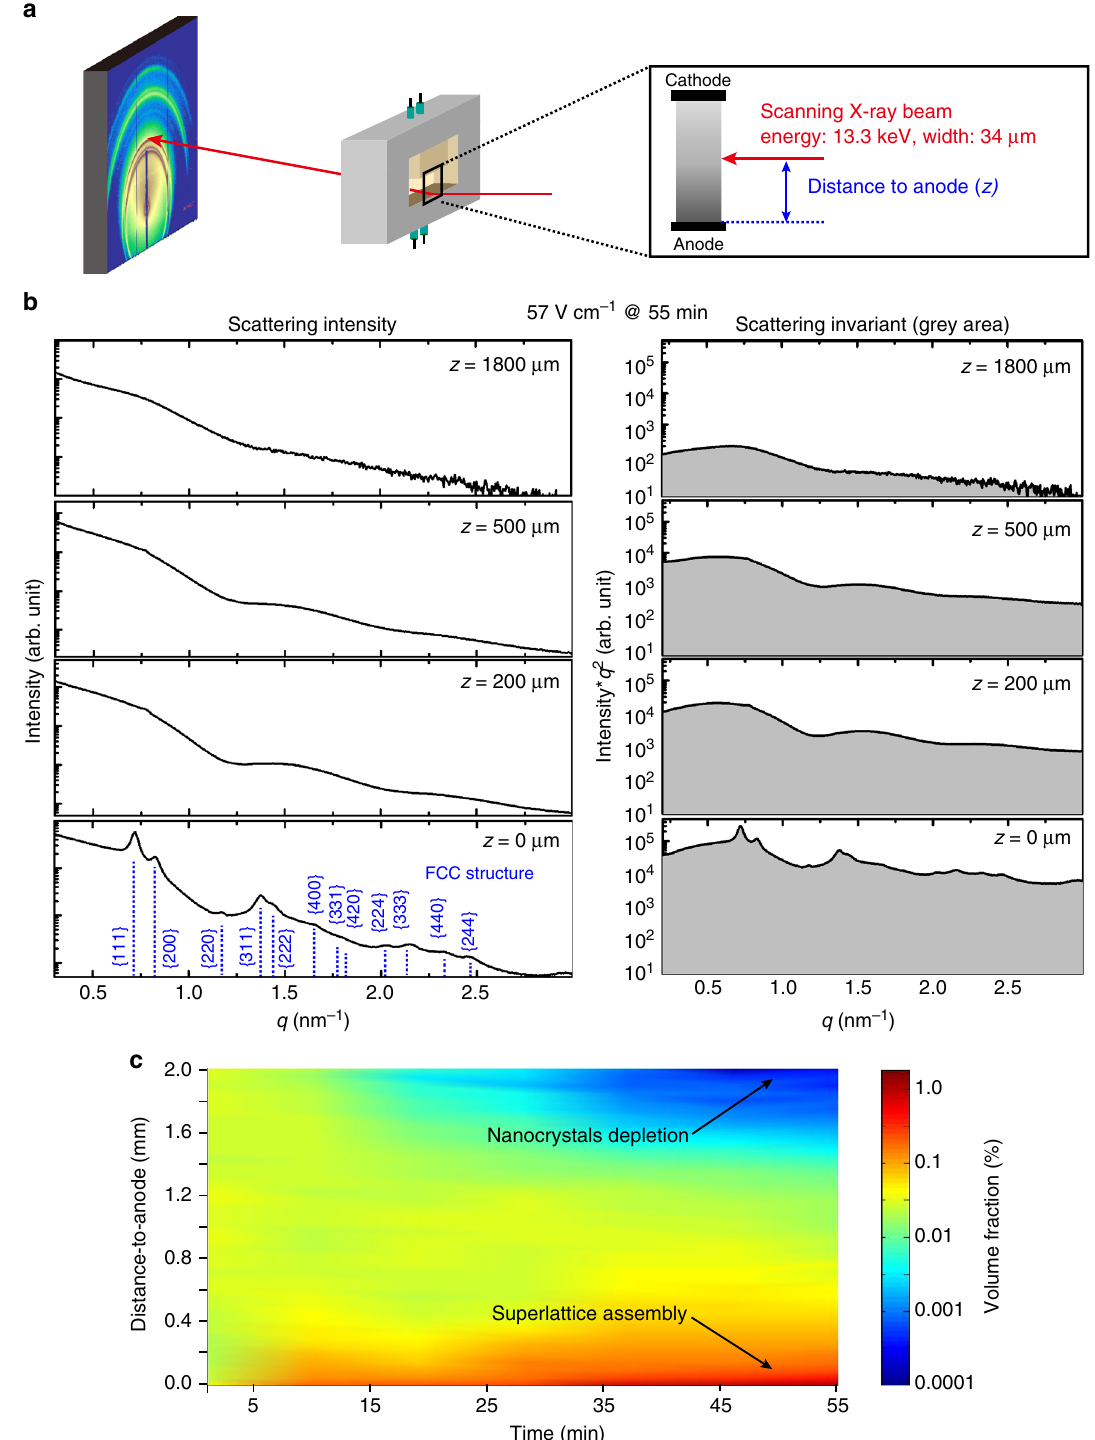
Fig. 3 In situ space- and time-resolved SAXS to probe the electric fi eld-driven assembly system. a Experimental setup of in situ SAXS experiments. b Left: scattering intensity, plotted on a logarithmic scale, for nanocrystal solution at various distances to the anode surface ( z = 1800, 500, 200, and 0 µ m, from top to bottom), after applying a fi eld of 57 V cm − 1 for 55 min; and right: the corresponding Kratky plots that are displayed with the same scale to allow a direct visual comparison of invariant at difference locations. c Contour plot of the nanocrystal solution volume fraction against the distance to the anode and the duration of applied electrical fi eld of 57 V cm − 1 , obtained in a space- and time-resolved SAXS measurement. The color re fl ects the volume fraction % as shown in the scale at